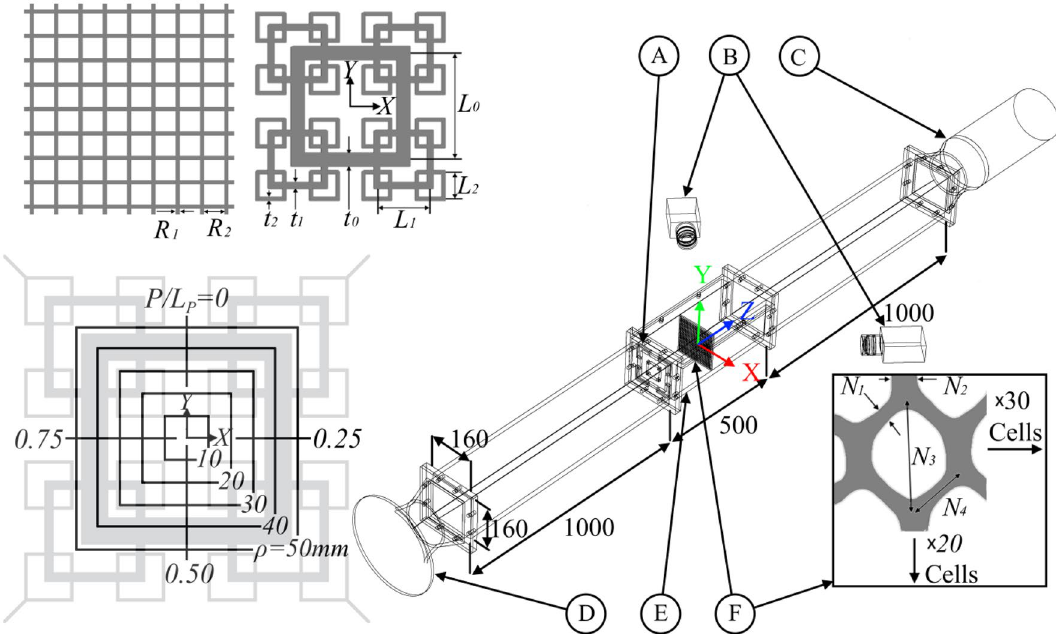
Figure 1. Clockwise from top left, regular and fractal square grid, experiment schematic, hexagonal cell net, concentric square coordinate system. Dimensions shown in Table 1. The experiment schematic consists of a grid/insert ( A ), two cameras ( B ), an axial draw-through fan ( C ), a bellmouth intake ( D ), the work area ( E ), and the hexagonal cell net ( F ). Note that the concentric square coordinate system introduces the parameter ρ which indicates the shortest distance from the square to its centre, and P/L P a normalised parameter that varies from 0 to 1 along the square perimeter. (note: prepared in Paint.net 4.2.14, https:// www. getpa int. net).